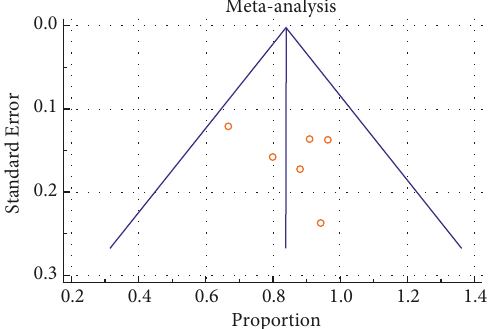
Figure 5: Funnel plot of studies regarding PP at I year in EVTRS group by Egger test.